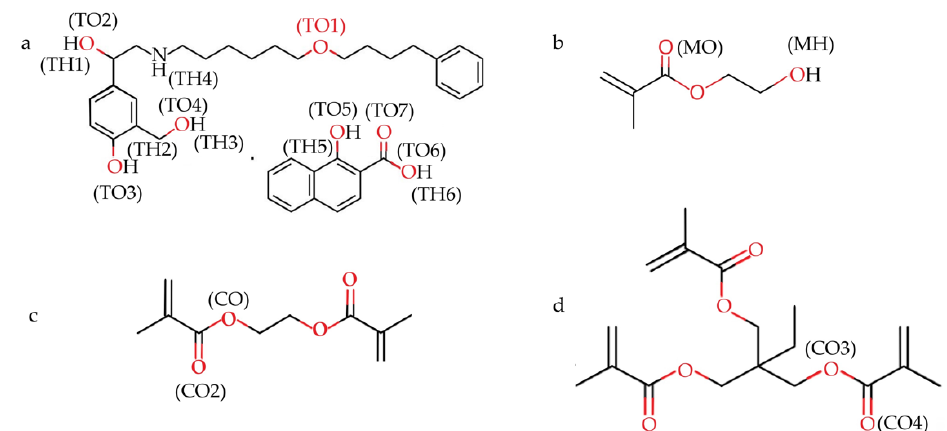
Figure 1. Chemical structure of SLX ( a ), HEMA ( b ), EGDMA ( c ), and TRIM ( d ), and atoms studied with RDFs.